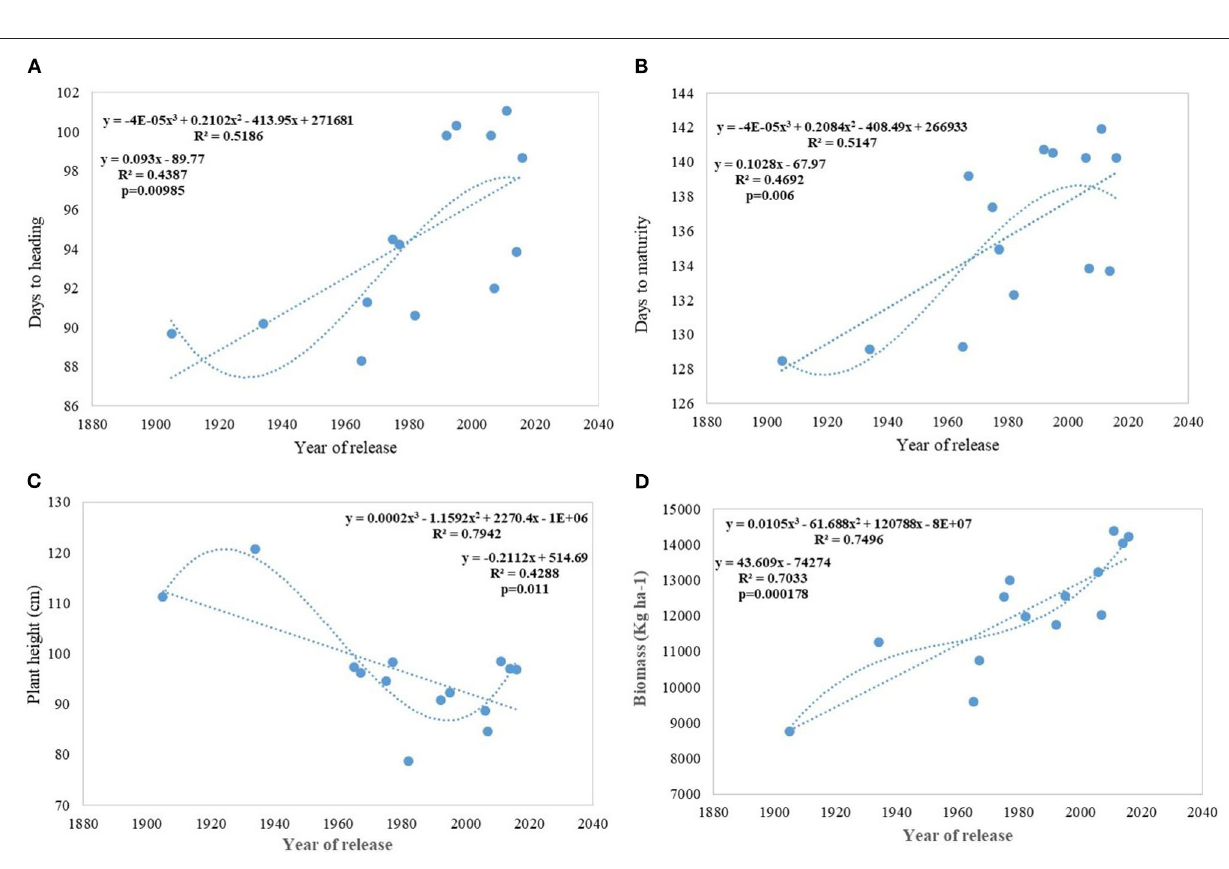
Frontiers in Plant Science |